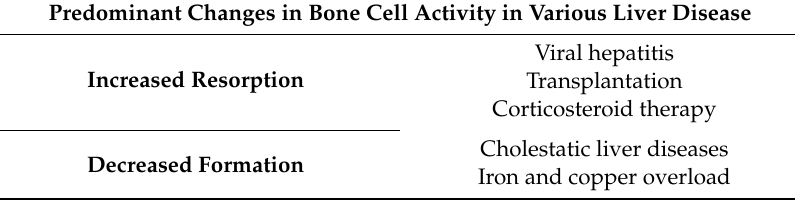
Table 2. Predominant changes in bone in various liver